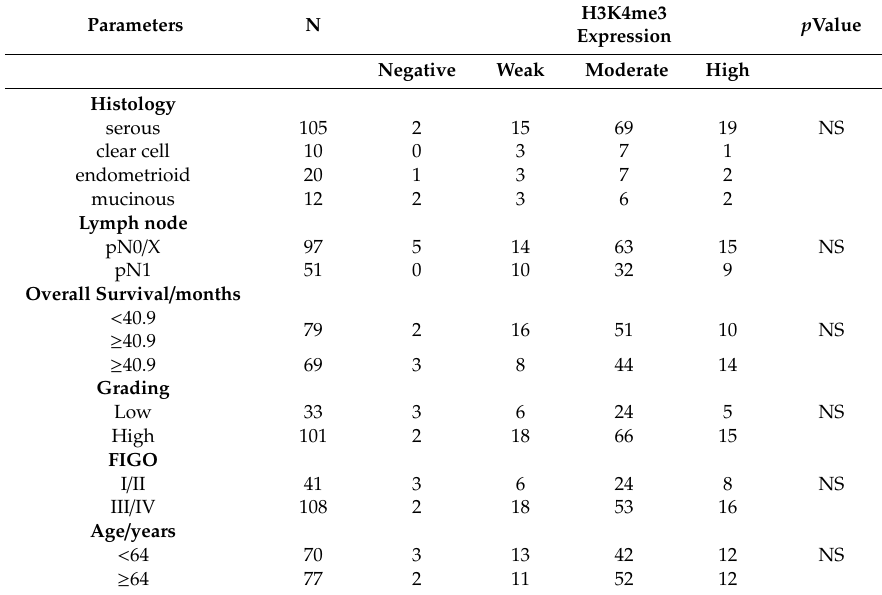
Table 1. Expression profile of H3K4me3 staining regarding clinical and pathological characteristics.